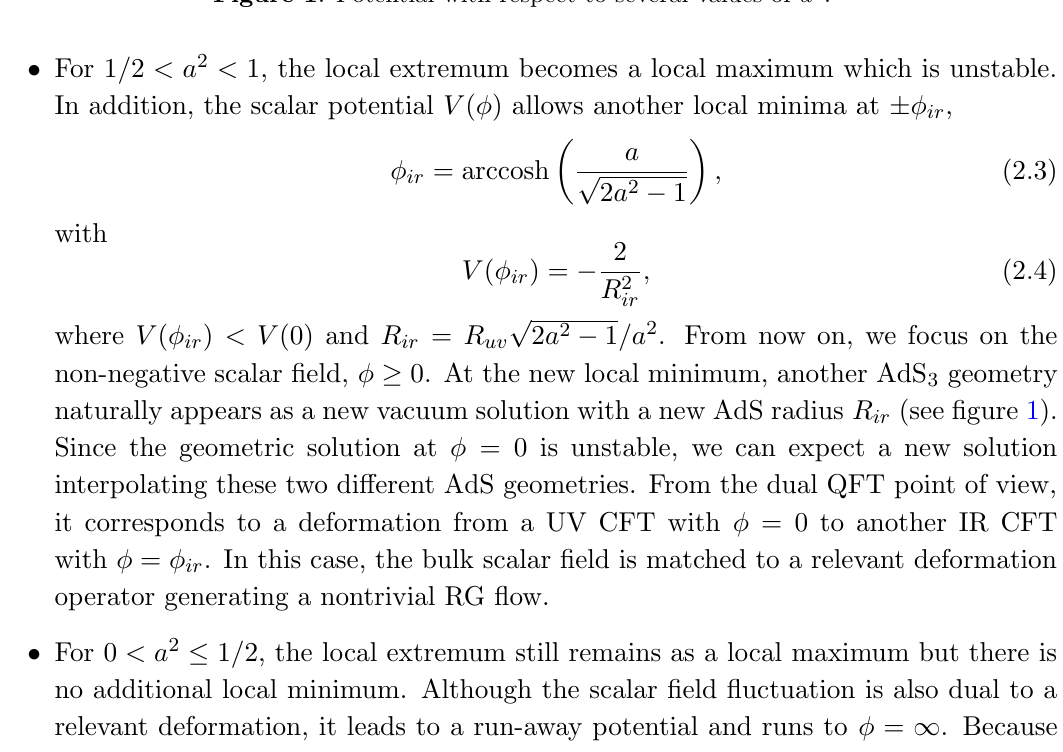
Figure 1 . Potential with respect to several values of a 2